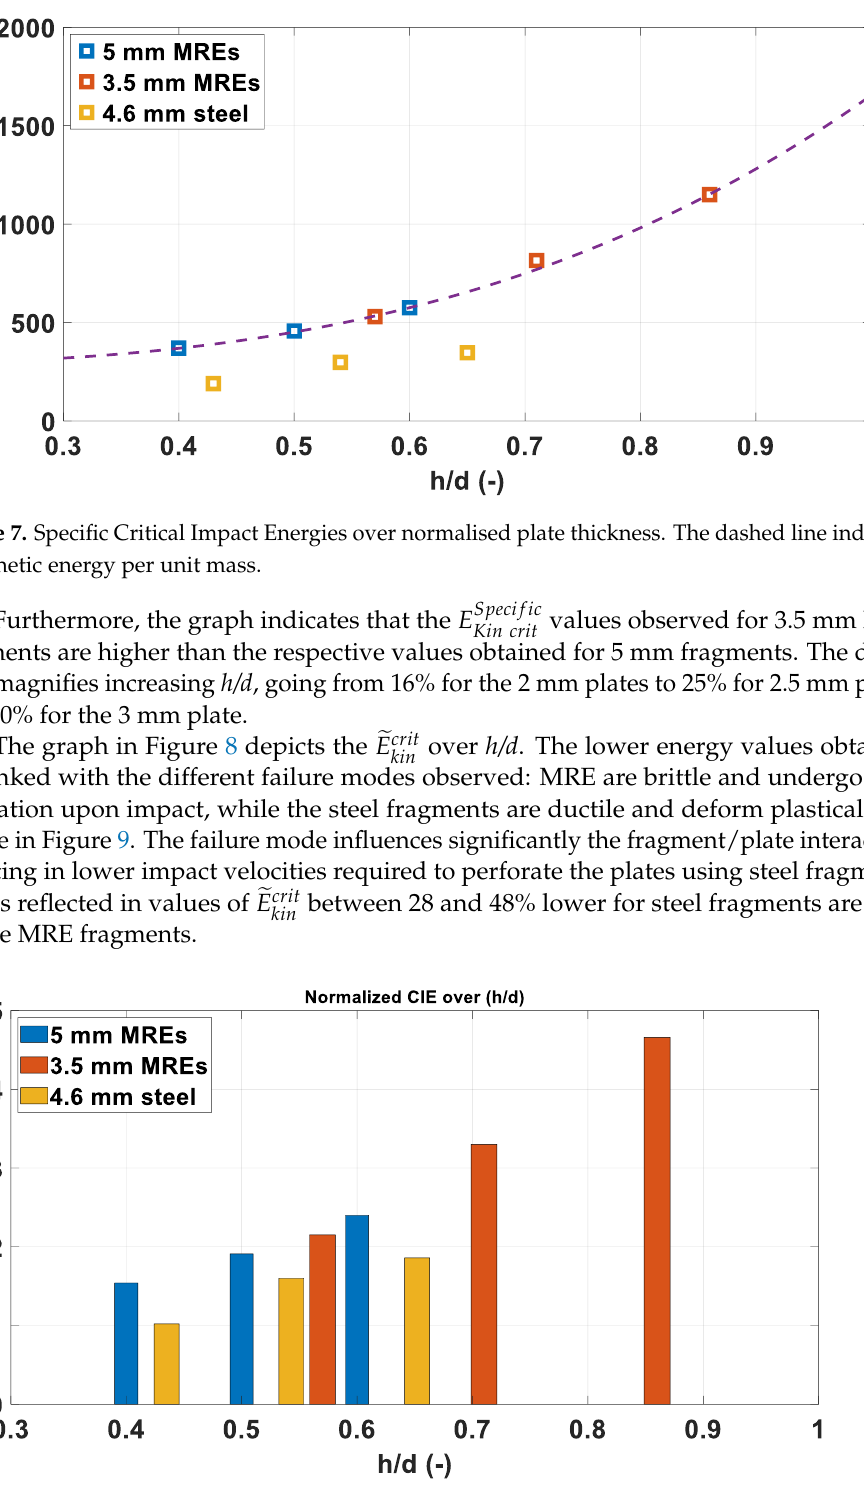
Figure 8. Plot of estimated values of 𝐸̃ 𝑘𝑖𝑛𝑐𝑟𝑖𝑡 over normalised plate thickness.